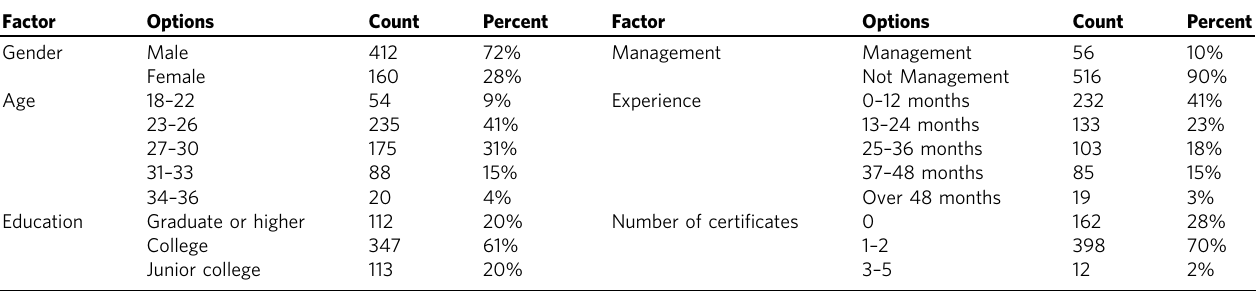
Table 1 Descriptive statistics of respondents ’ basic information.